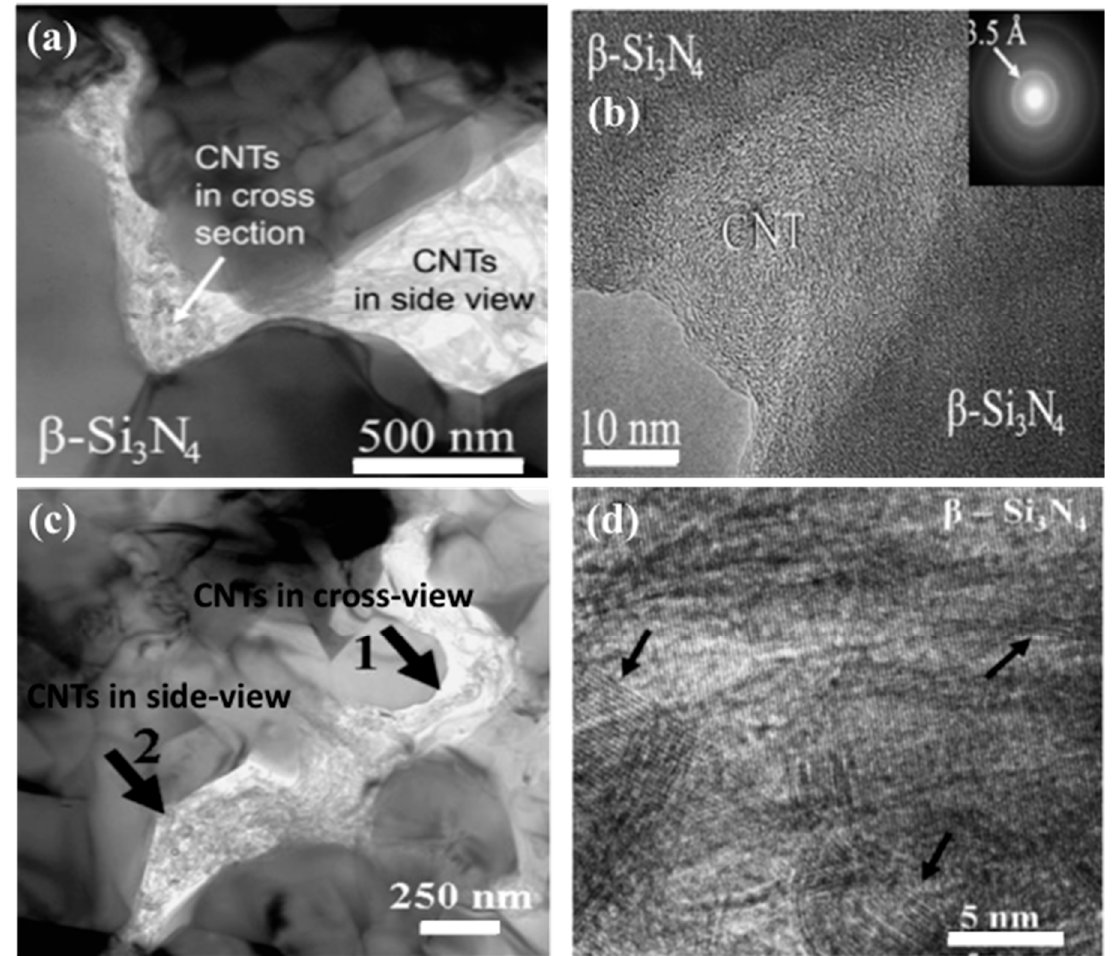
Figure 4. CNT-reinforced Si 3 N 4 composites: ( a ) Si 3 N 4 with 1 wt.% CNTs prepared by ball milling, CNTs are located in porosities enclosed with β -Si 3 N 4 grains; ( b ) HREM revealed that the CNTs were embedded between two β -Si 3 N 4 grains and electron diffraction confirmed the presence of CNTs with good contact between nanotubes and the surface of silicon nitride grains; ( c ) TEM image of Si 3 N 4 + CNT composite prepared by attrition milling. CNTs are located in porosities between Si 3 N 4 grains. ( d ) HREM image shows the silicon nitride-CNTs interfaces [45]. Reproduced from Ref. [45] with permission from Elsevier.